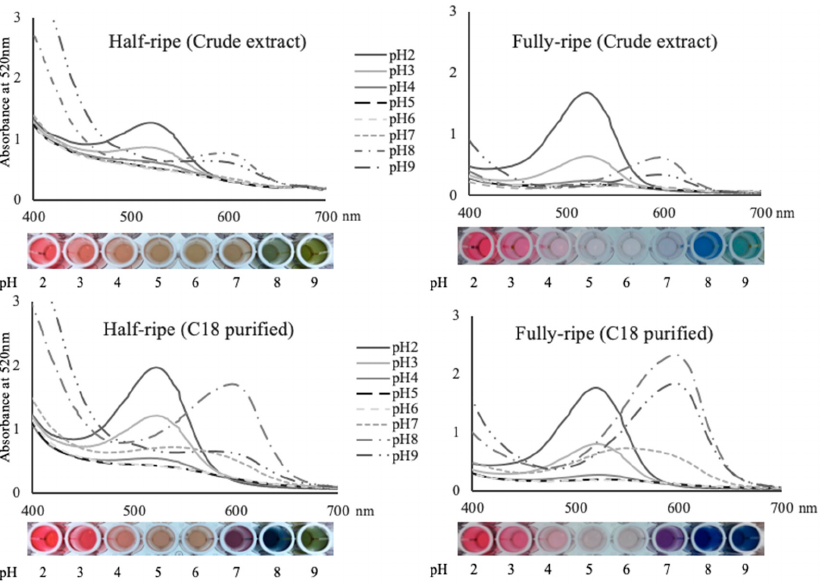
Figure 3. Spectral characteristics of American elderberry ‘Nova’ extracts at two ripening stages before and after C-18 semi-purification in pH 2–9 buffers. Data was collected 1 h after mixing. Table 3. Spectrophotometric ( l vis-max , nm) and colorimetric (CIE-L*, C*, h*) data of half and fully-ripe ‘Nova’ extracts before and after C-18 semi-purification in pH 2–9 buffers ( n = 3). Data was collected 1 h after mixing.